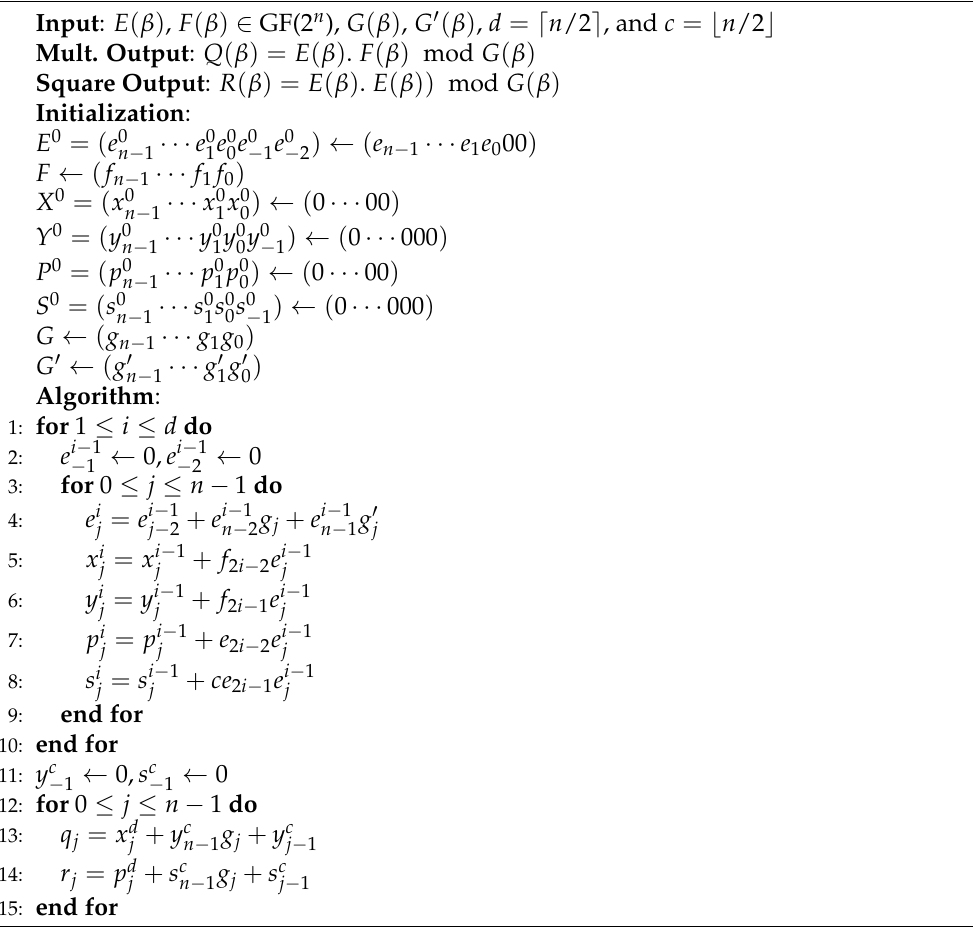
Algorithm 2 Bit-level form of the bipartite multiplication and squaring